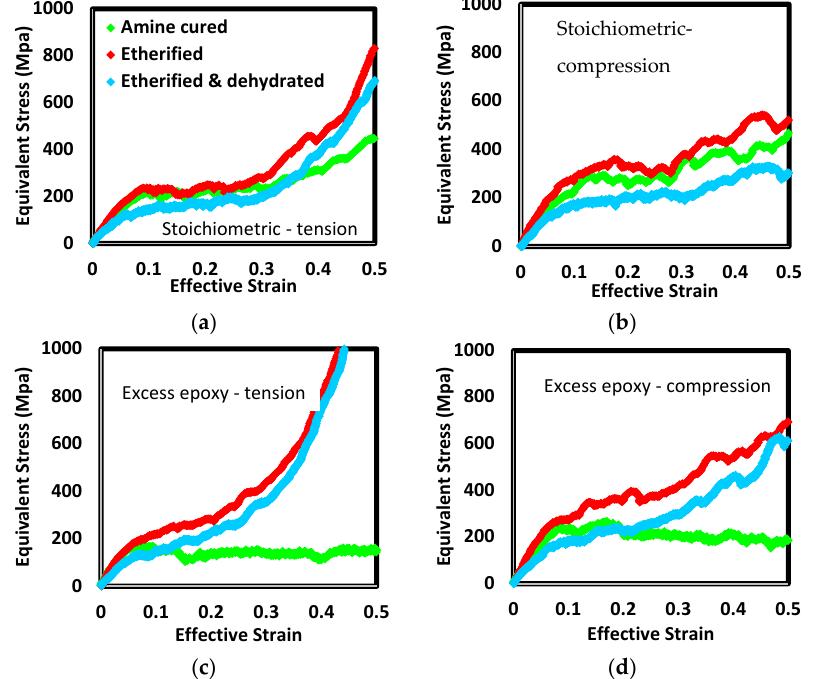
Figure 13. Equivalent stress verses effective strain for uniaxial tension ( a , c ) and compression ( b , d ) for short-chain resin at constant effective strain rate. Stoichiometric and excess-epoxide formulations are presented in ( a , b ) and ( c , d ), respectively.